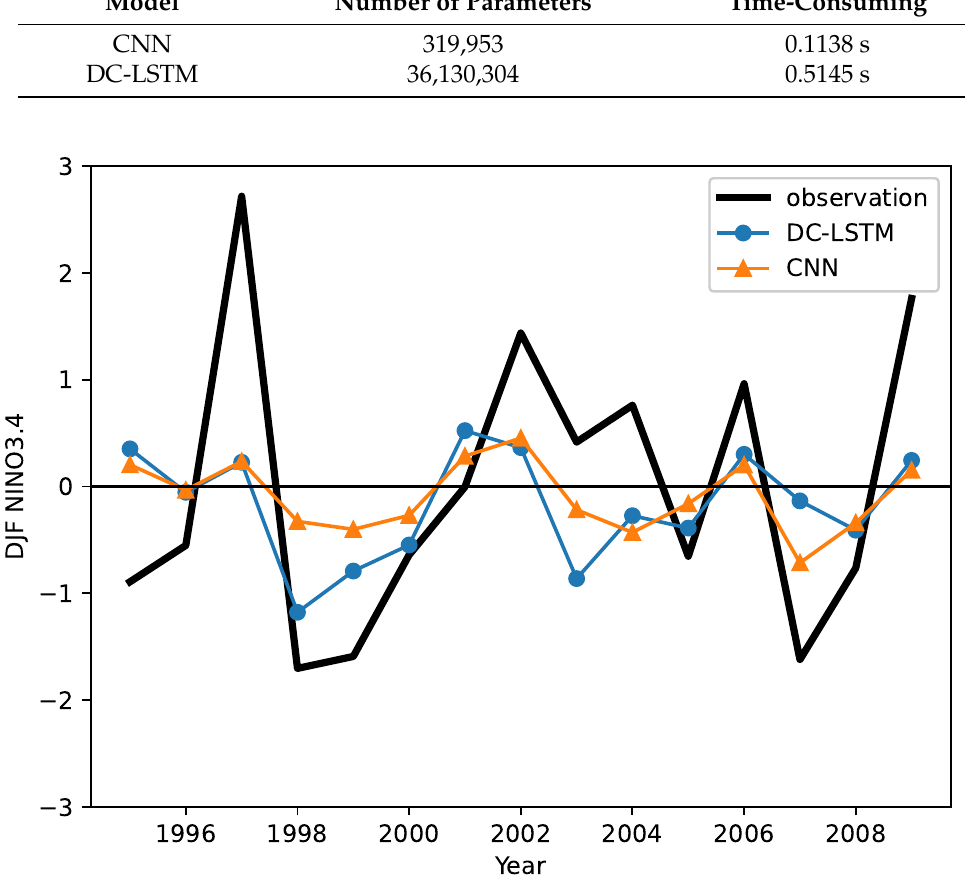
Figure 9. Time series of DJF season Nino3.4 indexes for a 20-month-lead forecast using the CNN model (orange) and the DC-LSTM model